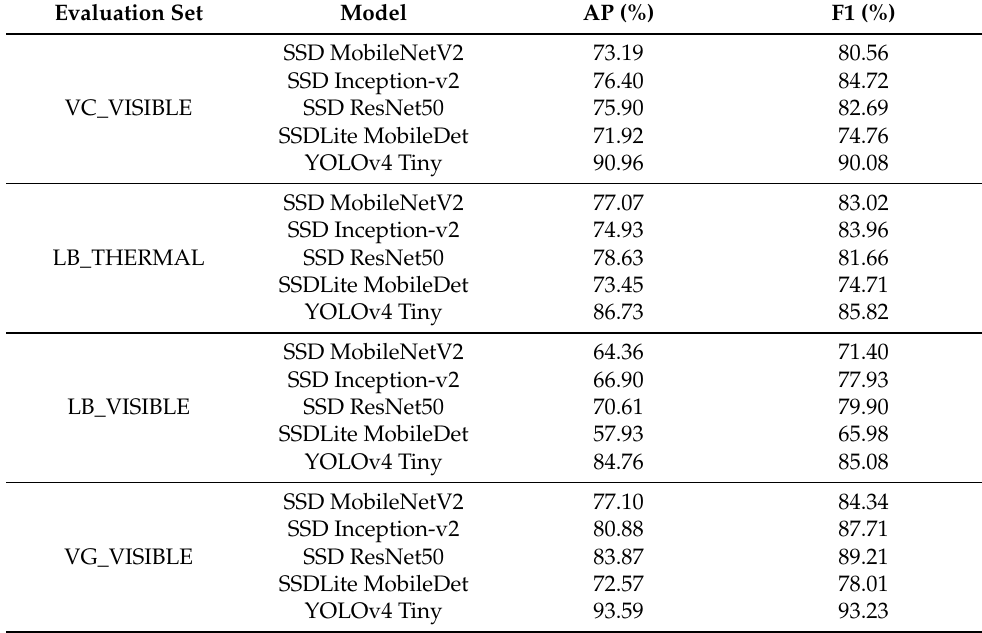
Table 6. Evaluation results for experiment #1 in terms of AP and F1 score considering all detections (confidence threshold of 0%).